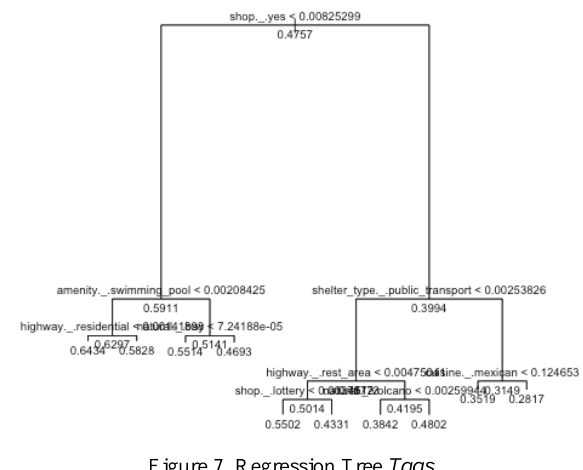
Figure 7. Regression Tree Tags